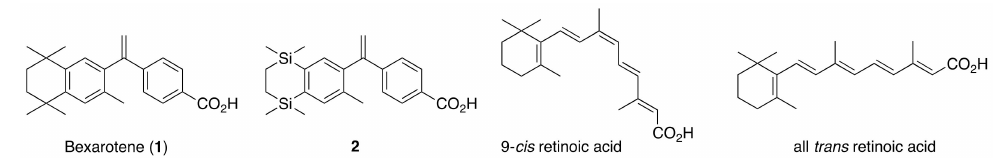
Figure 1. Structures of bexarotene ( 1 ), disilabexarotene ( 2 ), 9- cis retinoic acid, and all trans retinoic